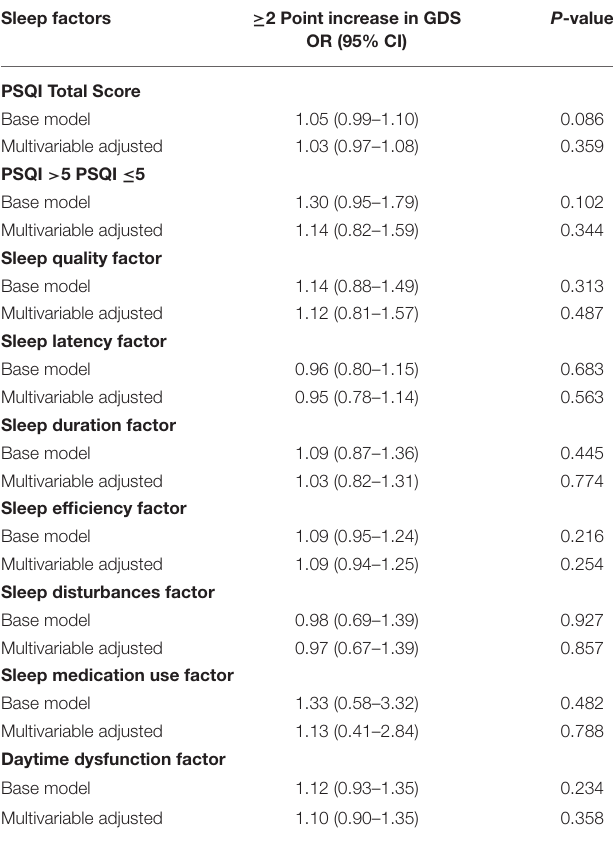
TABLE 4 | Associations between baseline sleep disturbance and odds of increased depressive symptoms at the 3-year follow-up. P Sleep factors ≥ 2 Point increase in GDS OR (95% CI)